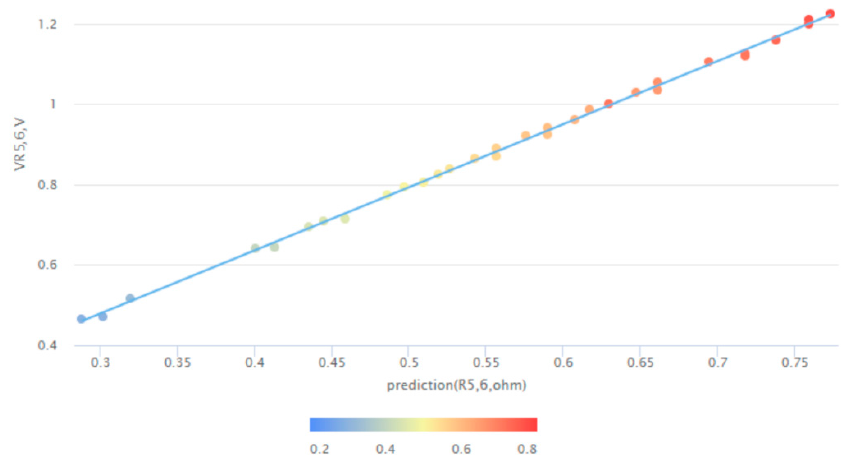
Figure 10. Predicted dependence between R 5,6 and V R 5,6 .